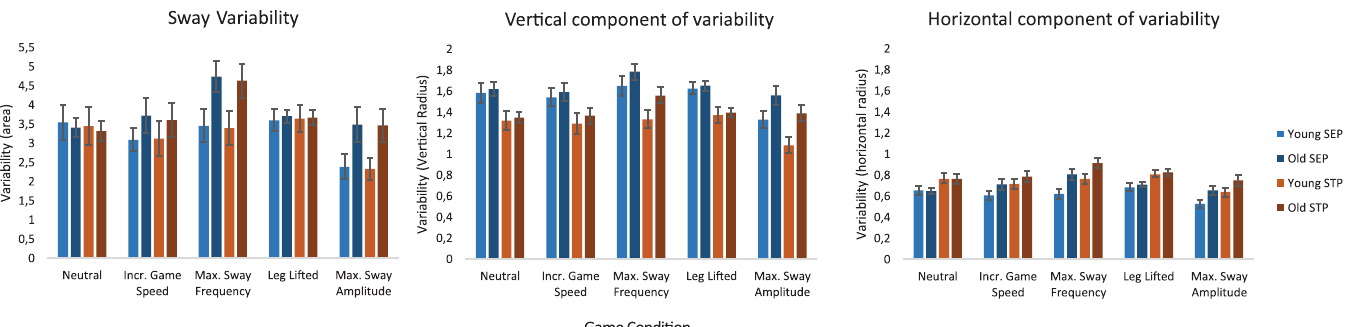
Fig 5. Sway variability and its vertical and horizontal components in different sway phases. Blue and red bars indicate the variability in the Sway Endpoint Phases (SEP), and Sway Traveling Phase (STP) respectively. Light and dark bars indicate young and older adults respectively. Error bars indicate 1 SEM. Note that the variability is a measure of distance related to the nodes on the SOM, hence variability and its vertical and horizontal components are unitless.